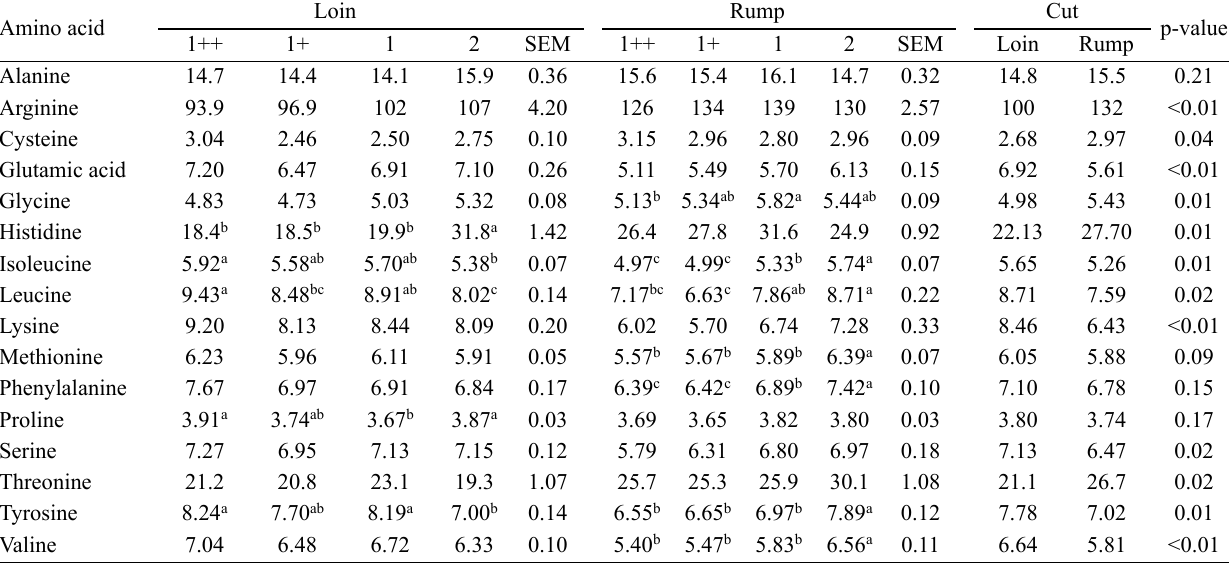
Table 8. The concentration (mg/100 g) of free amino acid of loin and rump with different quality grades in Korean cattle steers Amino acid